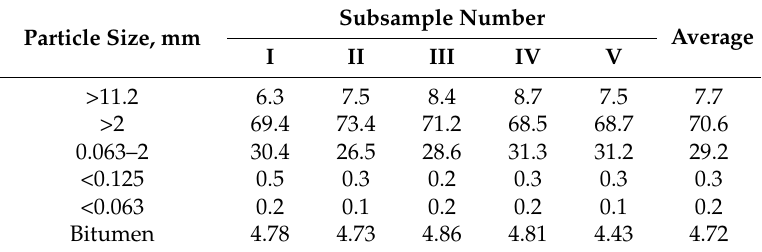
Table 3. RHMA mixture batch composition according to JMF (finite batching materials’ batch mass in kg in one RHMA mix batch of 3000